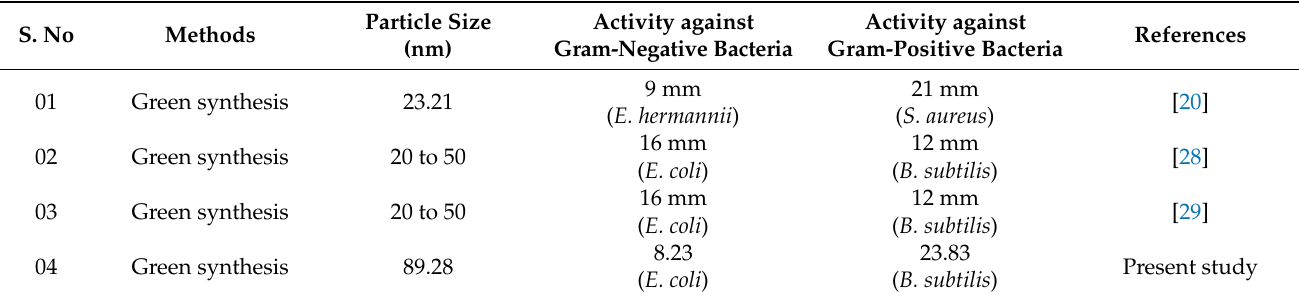
Table 5. Comparison of the present work with the reported data for NiO